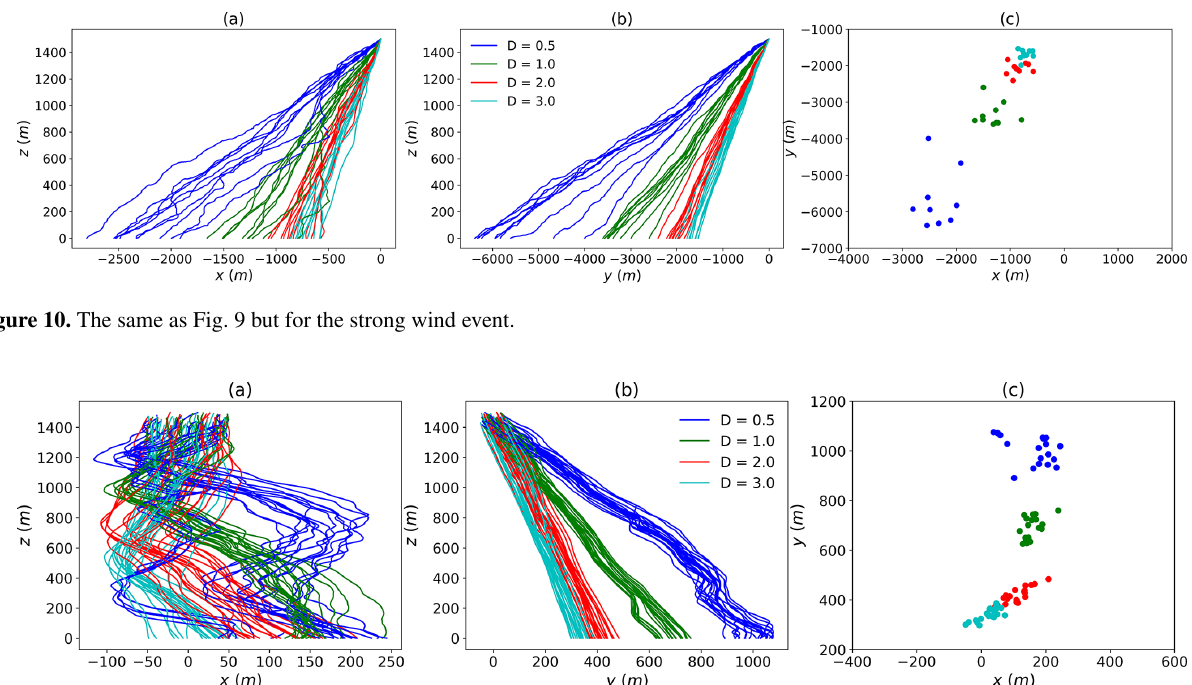
Figure 11. (a, b) Trajectories of drops of various sizes falling from a 100m cubic voxel centred on a ( 0 , 0 , 1450 ) position, projected on the (x,z) and (y,z) plane, respectively. The low wind event is used. For each size, the 20 drops are dropped every 15s (hence over a total duration of 5min). A single realization of the wind shift field is used. (c) Position of the ground impact of the various drops.